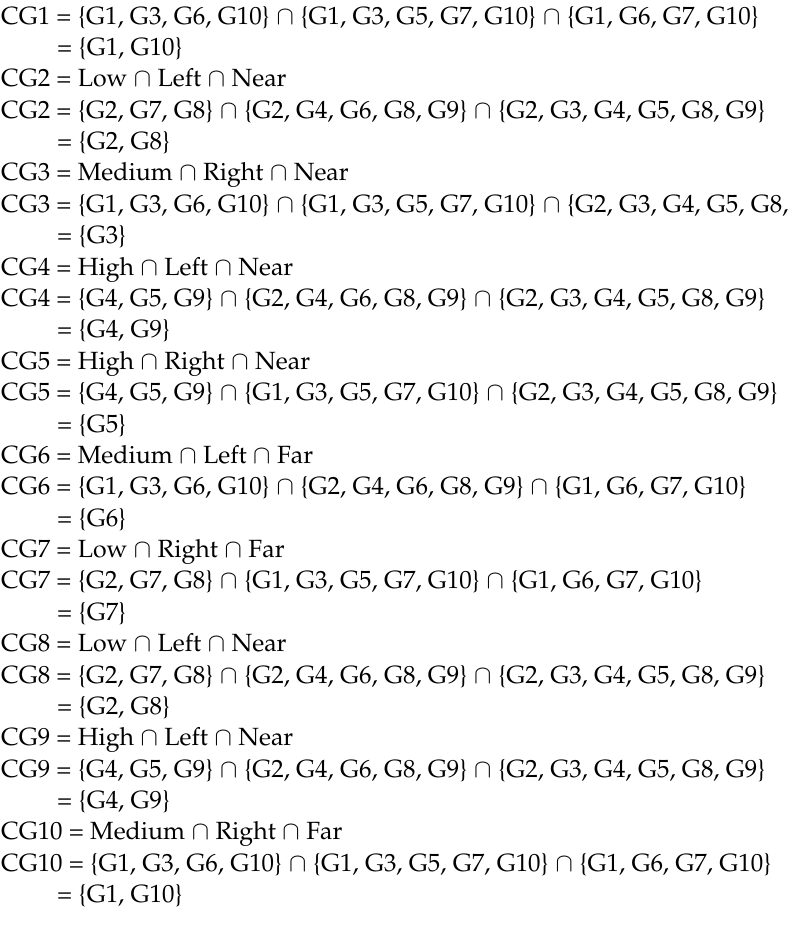
Table 3. Set of vehicle